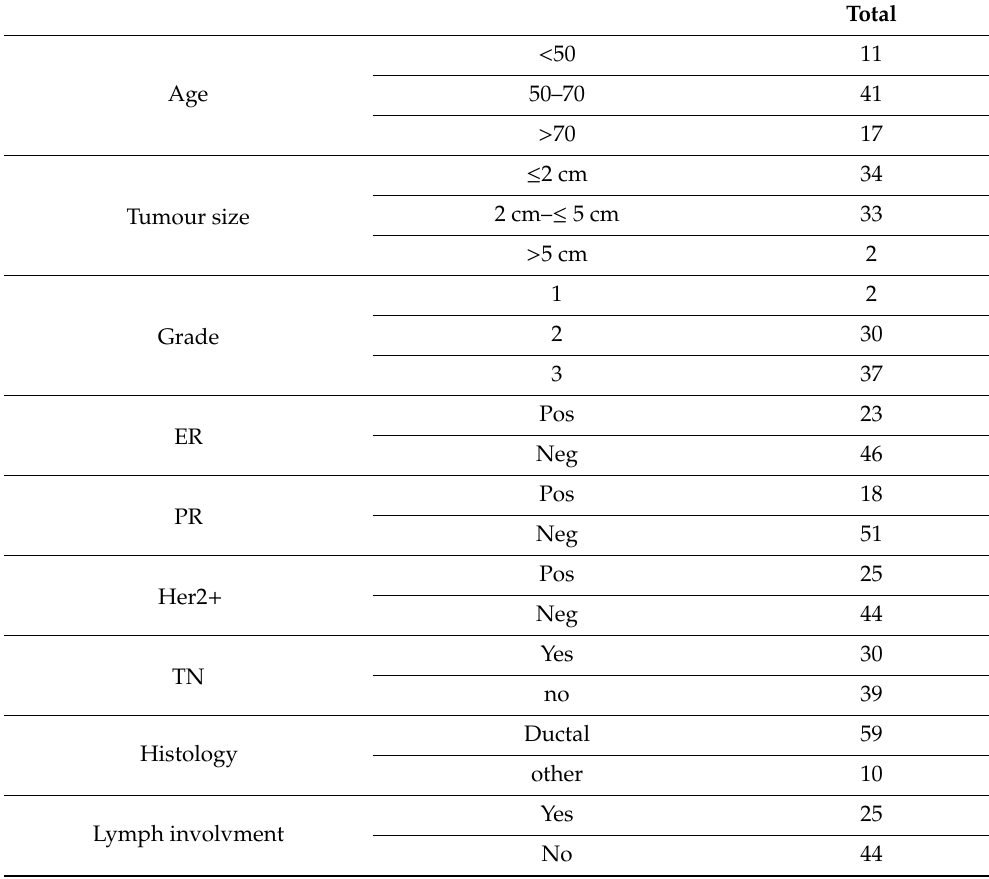
Table 1. indicates patient ages and the clinicopathological characteristics of the tumour tissue from 69 participants with breast cancer (TN = triple negative breast